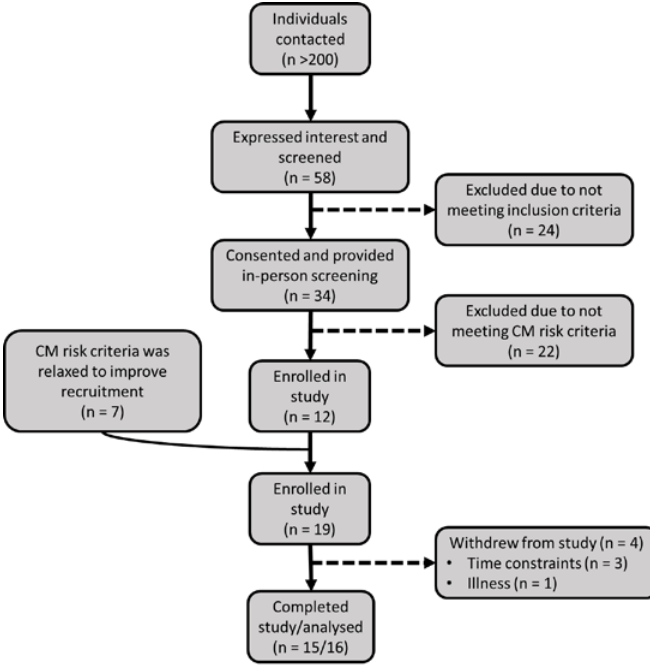
Figure 1. Study flow chart. CM: cardiometabolic. Participants consisted of 9 males and 7 females with n = 8 per dietary group. Baseline measurements are shown in Table 1. Although there were significant differences in body composition (body mass, p = 0.037; body mass index (BMI), p = 0.018; fat mass %, p = 0.010 and fat free mass (FFM) %, p = 0.010) between groups, leptin and leptin/adiponectin ratio (LAR) were the only biochemical markers significantly higher in the LCHF group (Leptin, 1.8-fold; LAR, 3.2-fold; both p = 0.007) compared to the HCLF group at baseline. Dietary intake analysis showed no differences in energy or macronutrient composition at baseline (Supplement